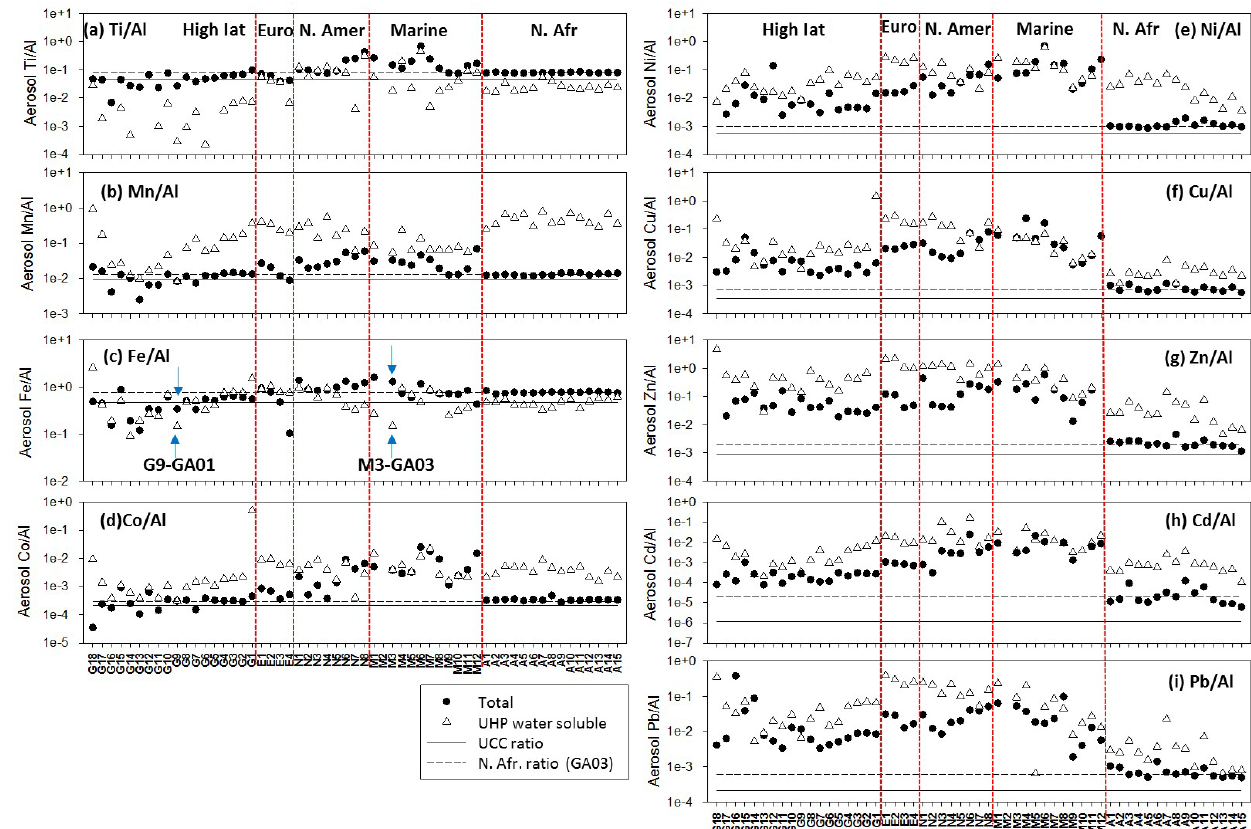
Figure 3. Elemental mass ratios (normalised to Al) of total (black circles) and UHP water-soluble (white triangles) TEs. The UCC elemental ratio (Rudnick and Gao, 2003) is indicated by the solid horizontal line, and the elemental ratio in North African sourced aerosols (Shelley et al., 2015) is indicated by the dashed horizontal line on each plot. The red vertical lines separate the aerosol source regions, which are labelled in panel (a) . Samples G9-GA01 and M3-GA03 are indicated by blue arrows in panel (c) (see text for